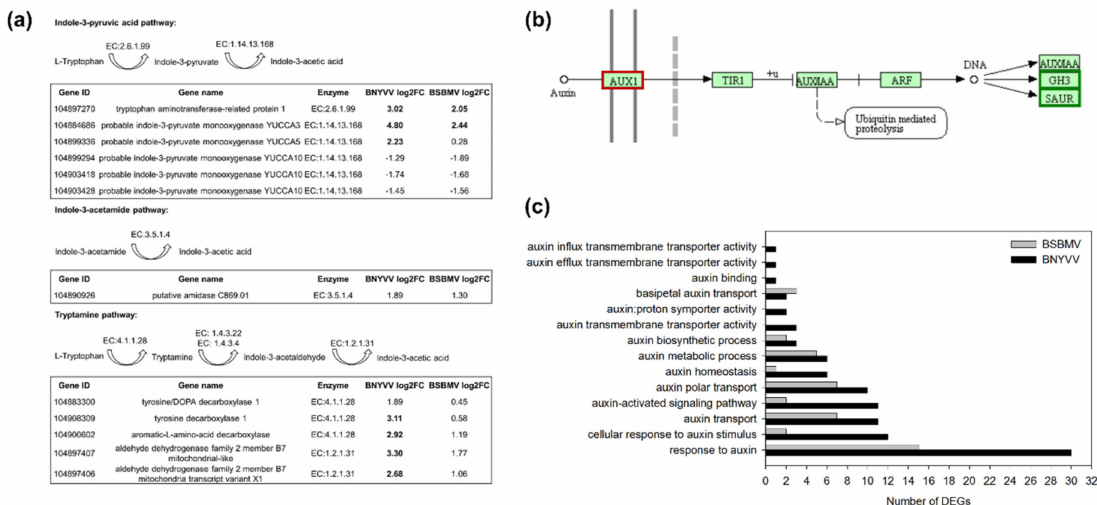
Figure 3. Interaction of BNYVV and BSBMV with auxin biosynthesis and auxin signalling pathways in sugar beet (susceptible genotype). ( a ) Log2 fold change (log2FC) of genes encoding proteins involved in the biosynthesis of auxin in sugar beet. Enzymatic steps of the indole-3-pyruvic acid, indole-3-acetamide and tryptamine pathways in sugar beet were retrieved from the Kyoto Encyclopedia of Genes and Genomes database (KEGG). DEGs above the threshold (log2 fold change > 2 or < − 2, p -value < 0.05) are highlighted in bold letters. ( b ) Auxin signal transduction pathway of sugar beet retrieved from the KEGG database. Components of the pathway are highlighted in red when only DEGs from BNYVV were mapped, whereas green indicates that DEGs from both viruses mapped to this component. ( c ) Number of DEGs belonging to gene ontology (GO) categories related to auxin signalling